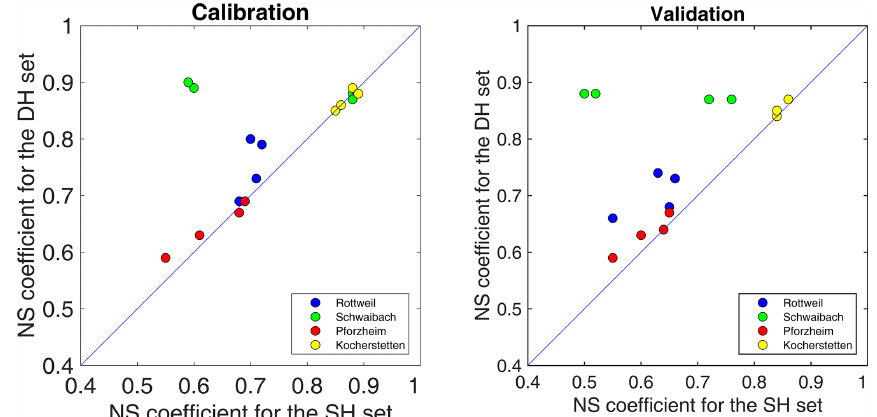
Figure 11. Comparison of the NS coefficient for different densities of raingauge networks; models were simulated based on hourly time steps.